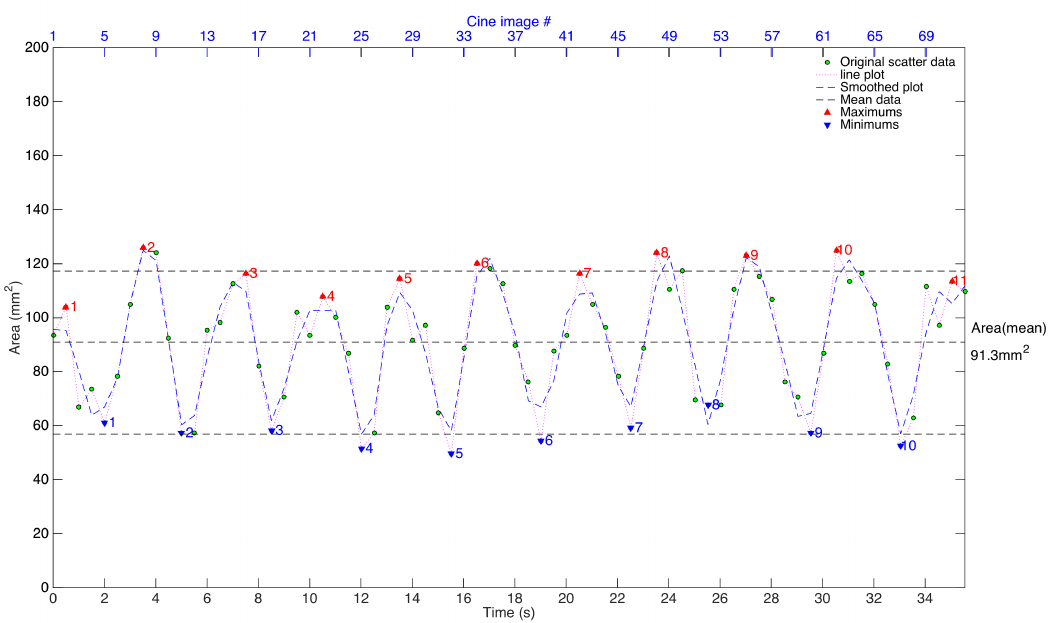
Figure 2. Changes in cross-sectional area of the airway across 72 consecutive images of cine MRI. The minimum and maximum airway dimensions are obtained by averaging all the minimums/valleys (down triangles) and maximums/peaks (up triangles) in the airway measure plotted as a function of time. The mean airway dimension is the average of all the 72 airway measures, representing the average size of the airway